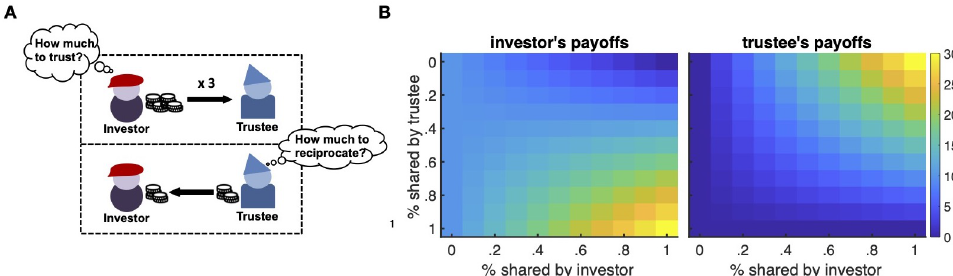
Figure 1. Investment game and payoff structure. The investment game (IG) is a sequential game where the investor receives an initial sum (endowment) and can decide whether to share any of this with the trustee (trust decision). The shared sum is then multiplied (e.g., tripled) and passed on to the trustee, who can decide to share back some of the received amount (reciprocity decision). In multiple one-shot or multi-round IGs, the same trial depicted is repeated multiple times with either a different trustee or the same trustee, respectively ( A ). Investor’s and trustee’s payoffs at the end of each trial for each possible action (in % of the available sum). The payoff value grid clearly shows the dilemma of the investor as a function of economic interests (payoff values). While the investor is incentivized by the payoff structure to share higher amounts, the trustee is incentivized to keep more of the received amounts ( B